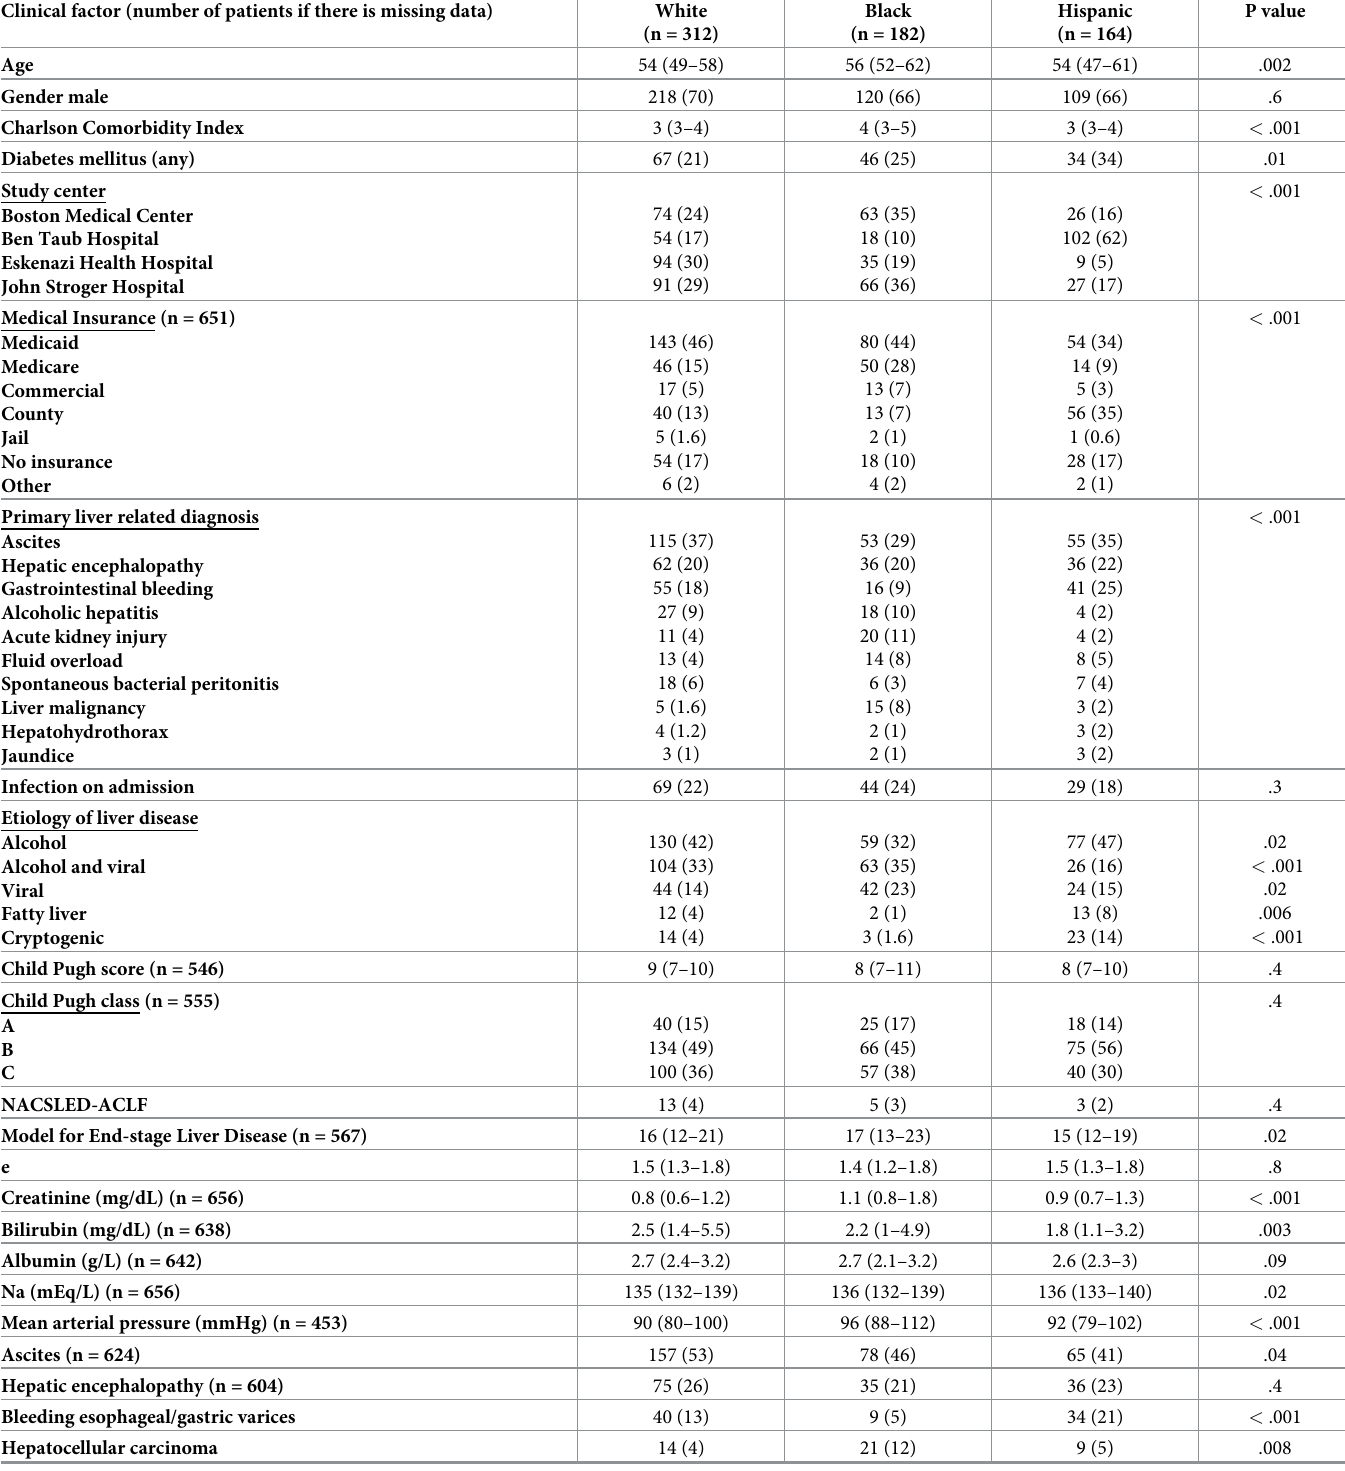
Table 6. Comparison of selected characteristics and outcomes of hospitalization in 659 White, Black, and Hispanic patients (23 Asian and 43 patients of other race were not included in this comparison due to the small numbers represented). Data are reported as number (percent) or median value (interquartile range). Clinical factor (number of patients if there is missing